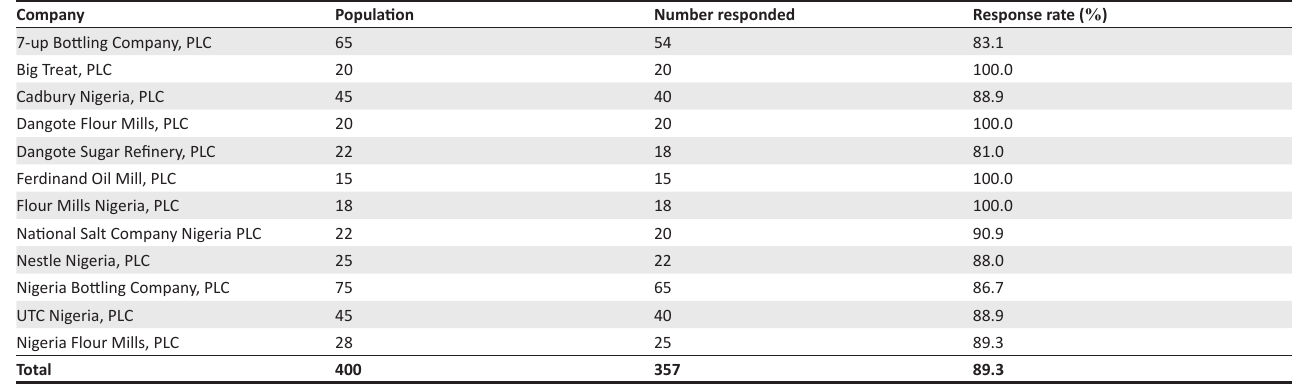
TABLE 1: Questionnaire administration and response